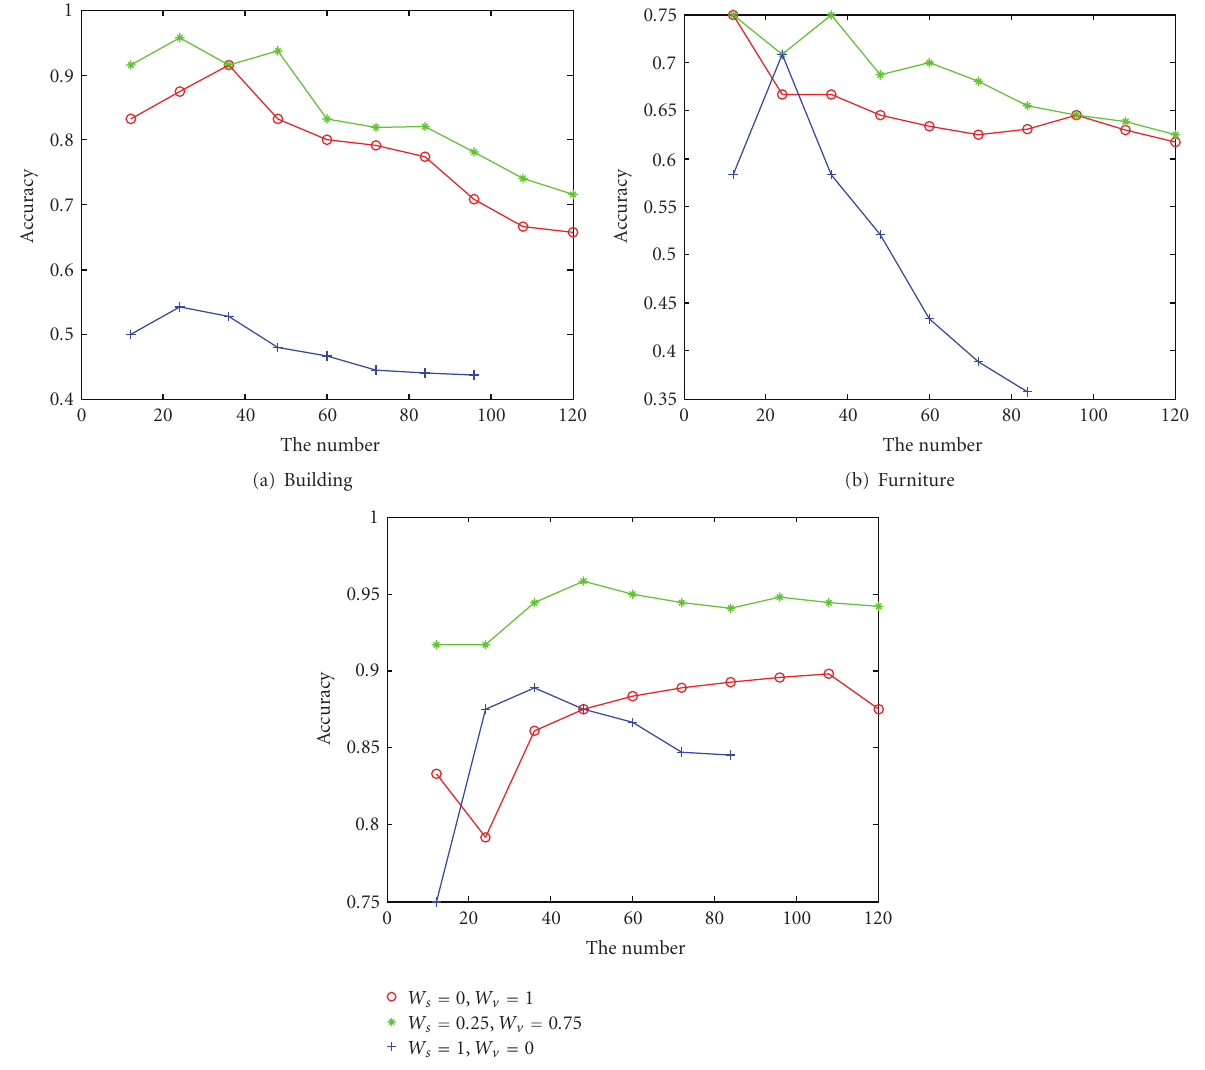
(c) Landscape Figure 6: Accuracy with varying weights of SR and VS. Table 2: Accuracy of retrieved